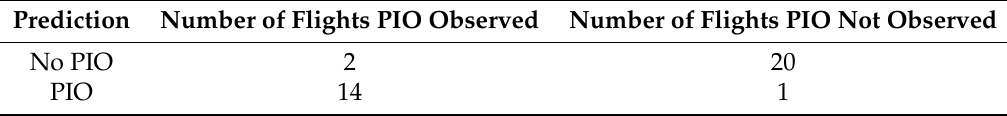
Table 3. “Phastball” flight test results for different values of elevator rate limit.